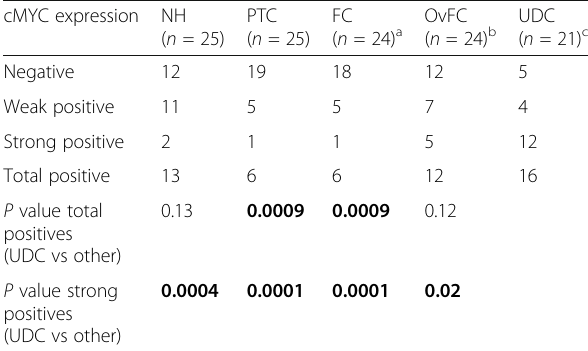
Table 3 cMYC nuclear expression in nodular hyperplasias and follicular cell-derived